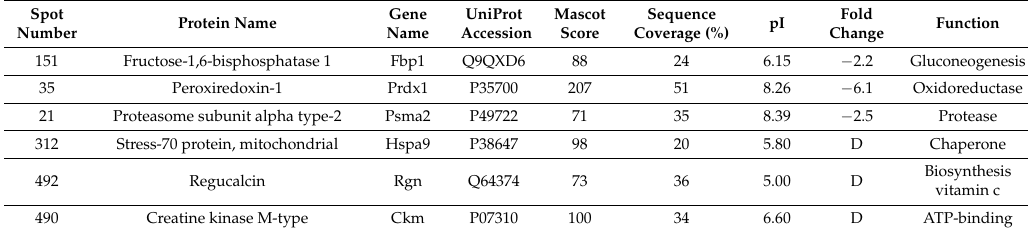
Table 2. Enrichment analysis of metabolic pathways and biological function of differentially expressed proteins.